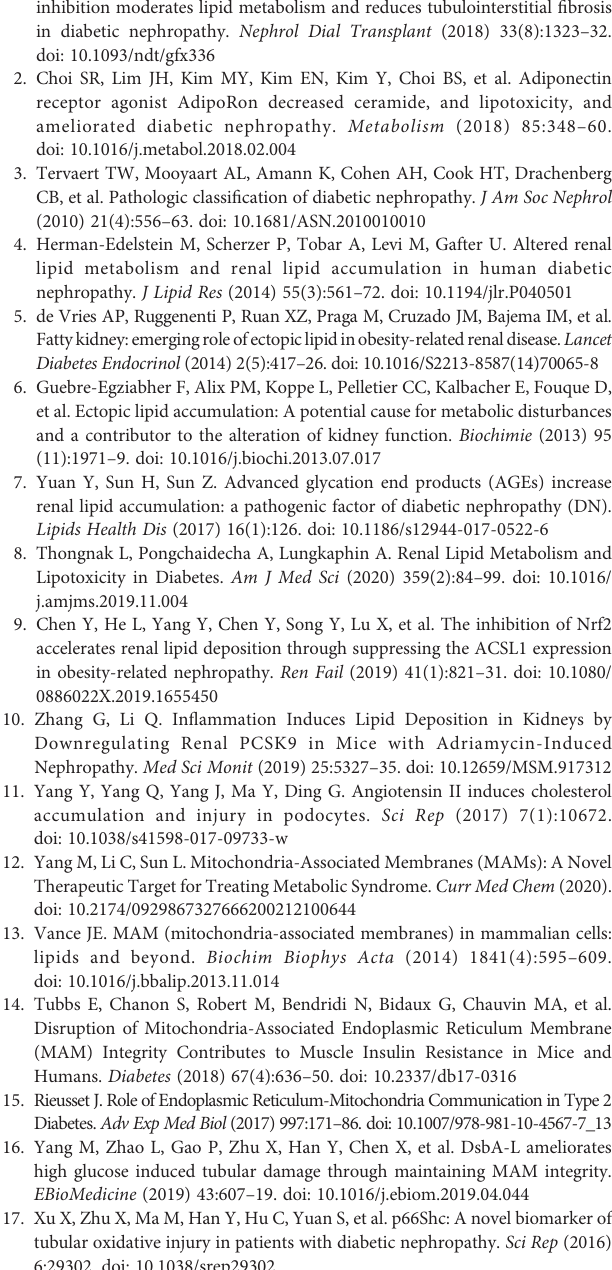
diagram representing the levels of VDAC1, Fis1, and Drp1. Experiments were performed at least three times for each donor, with a minimum of fi ve random fi elds taken per condition. Values are the mean±SD. *p < 0.05 compared with the control group; # p < 0.05 compared with the class IIa group. Supplementary Figure 2 | The integrity of the MAMs detected by TEM.